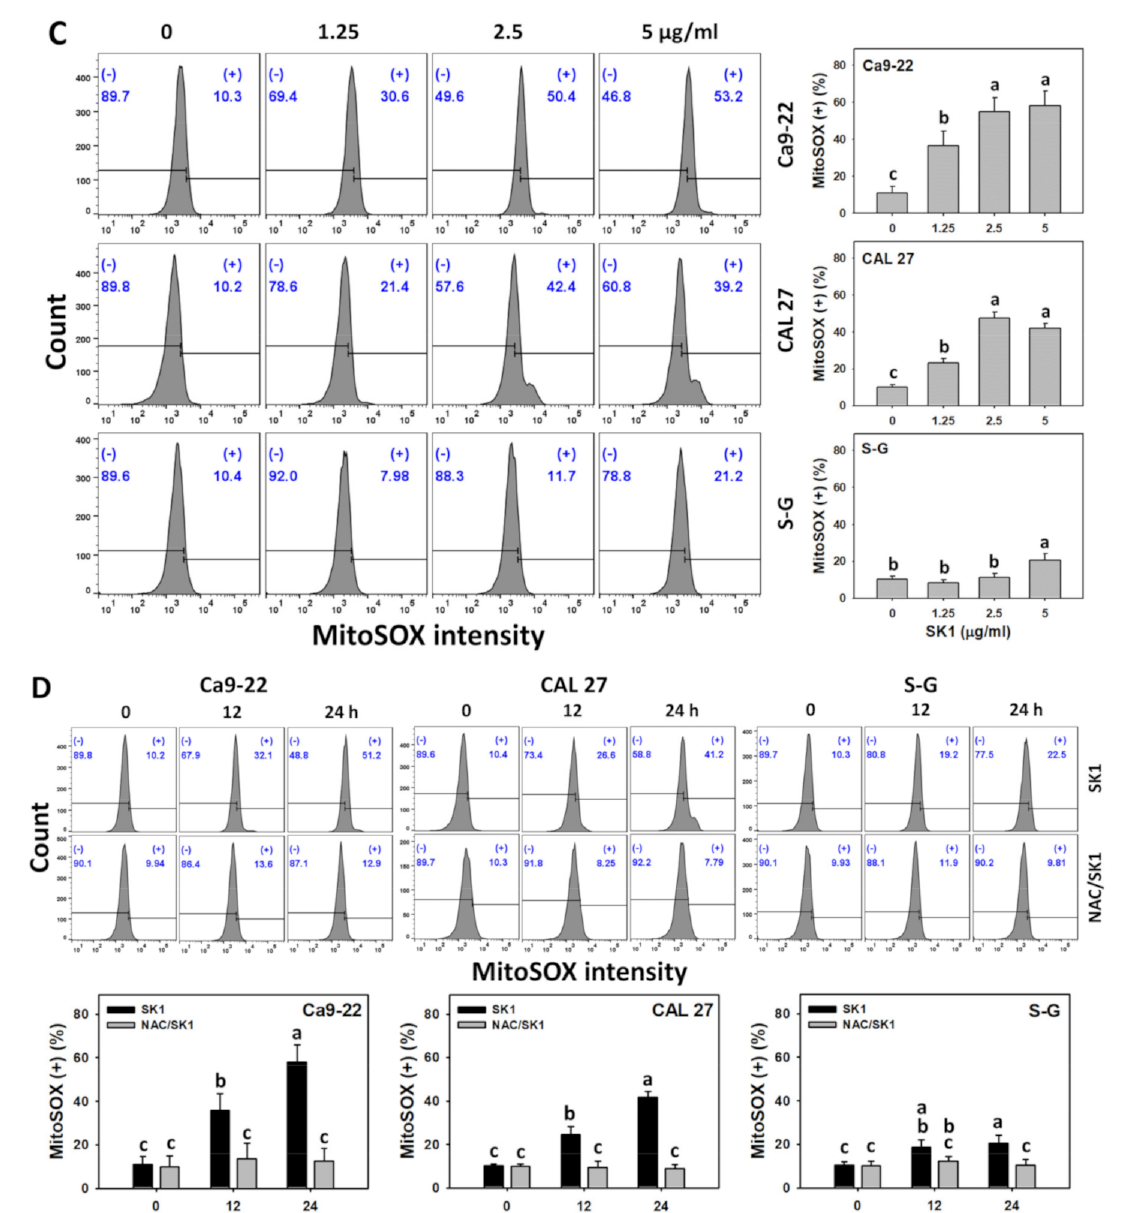
Figure 6. Oxidative stress effects (ROS and MitoSOX) of SK1. ( A , C ) ROS and MitoSOX assays of SK1. Non-malignant (S–G) and oral cancer (Ca9-22 and CAL 27) cells were treated with SK1 (0 (0.1% DMSO in medium), 1.25, 2.5, and 5 µ g/mL) for 24 h. ( B , D ) ROS and MitoSOX assays of NAC/SK1. NAC/SK1 indicated that cells were pretreated with NAC and posttreated with SK1 5 µ g/mL for 0, 12, and 24 h. (+) inserted at the histogram is counted for the percentage of ROS and MitoSOX (+)(%). Data, mean ± SD ( n = 3). Statistical software provided non-overlapping low-case letters indicate significant results for multi-comparison ( p <